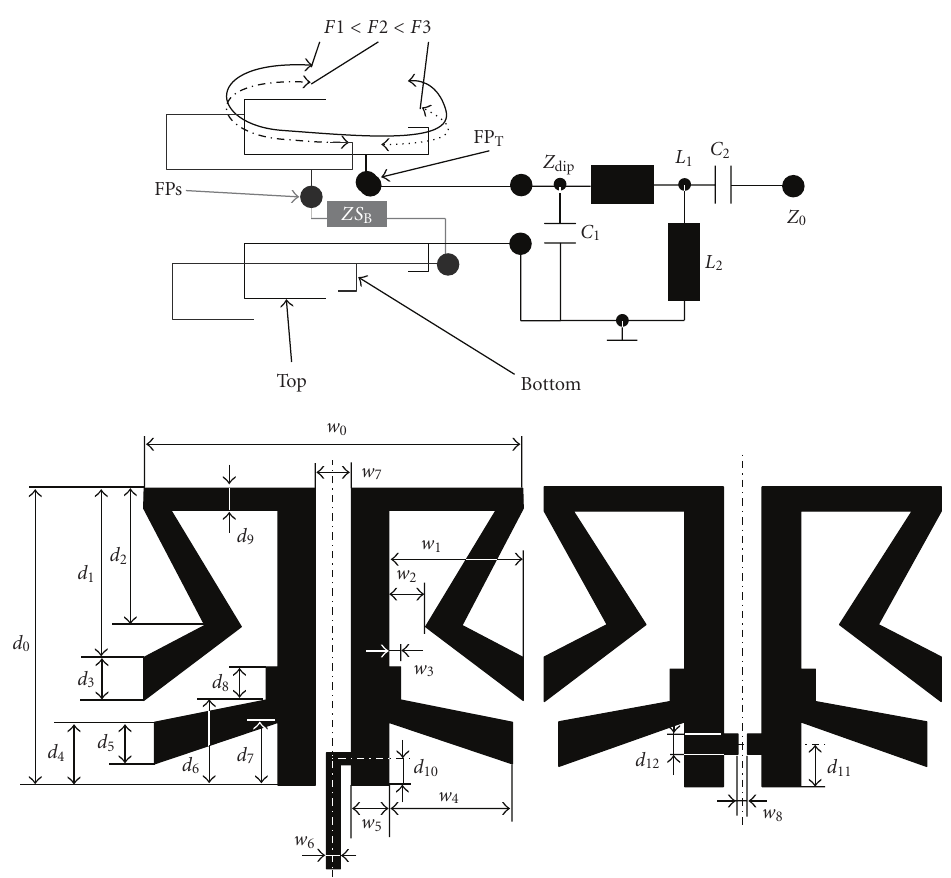
Figure 1: Schematic of the basic antenna configurations. L 1 and C 1 are distributed values due to the PCB and L 2 , C 2 , and ZS B are surface mount components; Z 0 is the line impedance (50Ohm) and Z dip ∼ 200Ohm. The d i ) and w i ) dimensions figured on the PCB top and bottom side are specific to the particular antenna